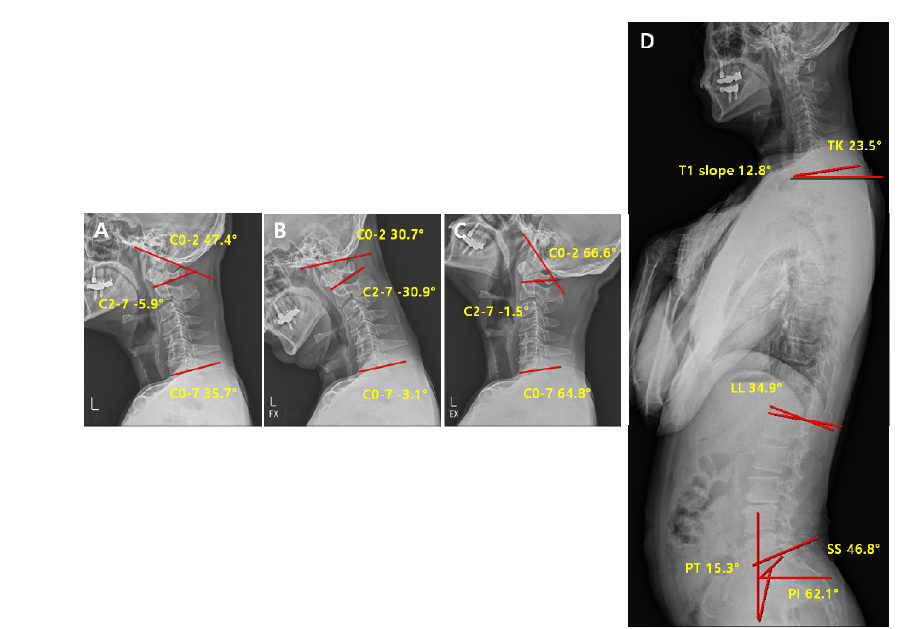
Figure 10. Pre-operative radiological parameters in the non-reducible non-lordosis group. Cervical spine lateral X-ray of neutral ( A ), flexion ( B ), extension ( C ) and whole-spine lateral X-ray ( D ).